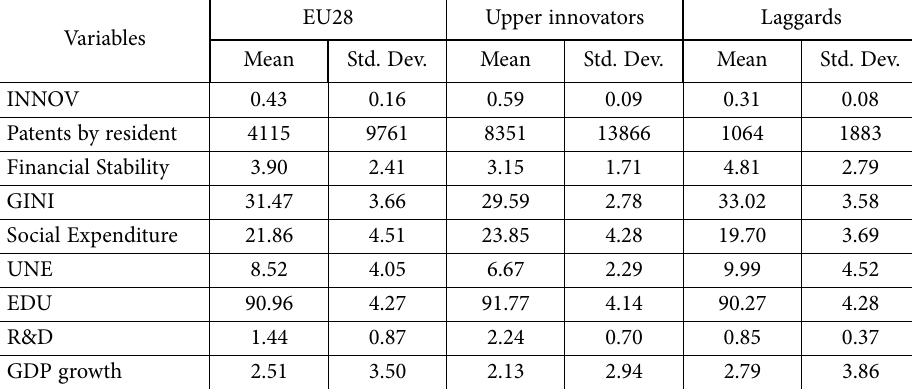
Table 2. Summary